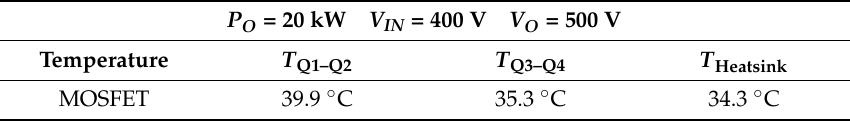
Table 3. Temperature Measurements for P O = 20 kW in SiC MOSFET after 15 min.